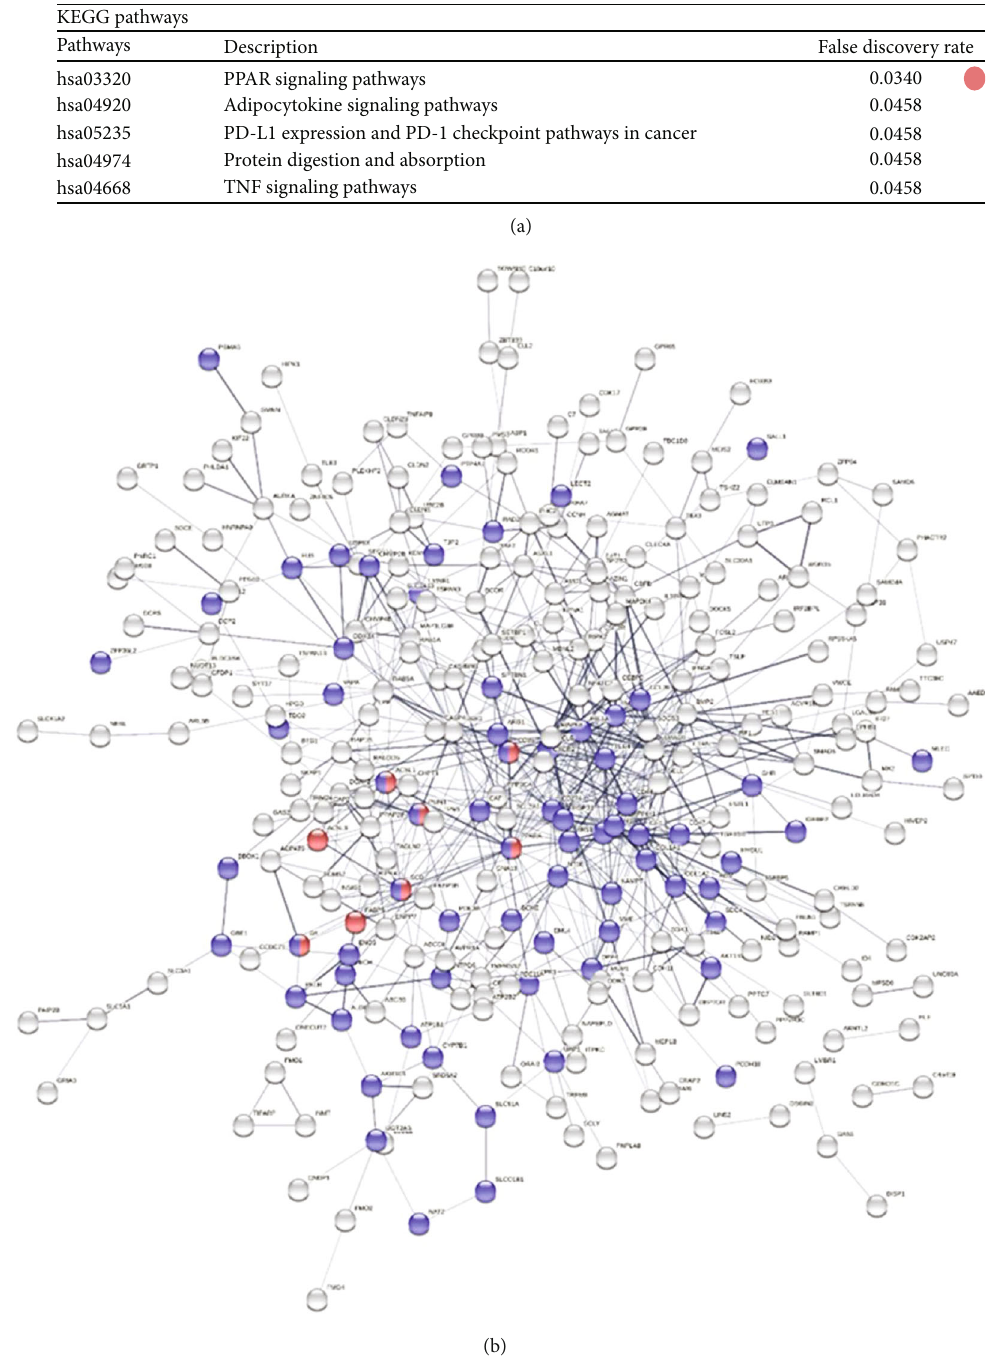
Figure 2: KEGG pathway enrichment and protein-protein network of human MAFLD DEGs. (a) Top 5 enriched pathways with signi fi cant FDR score and (b) protein-protein network illustrating PPARs signaling genes as red and liver-expressed genes as blue